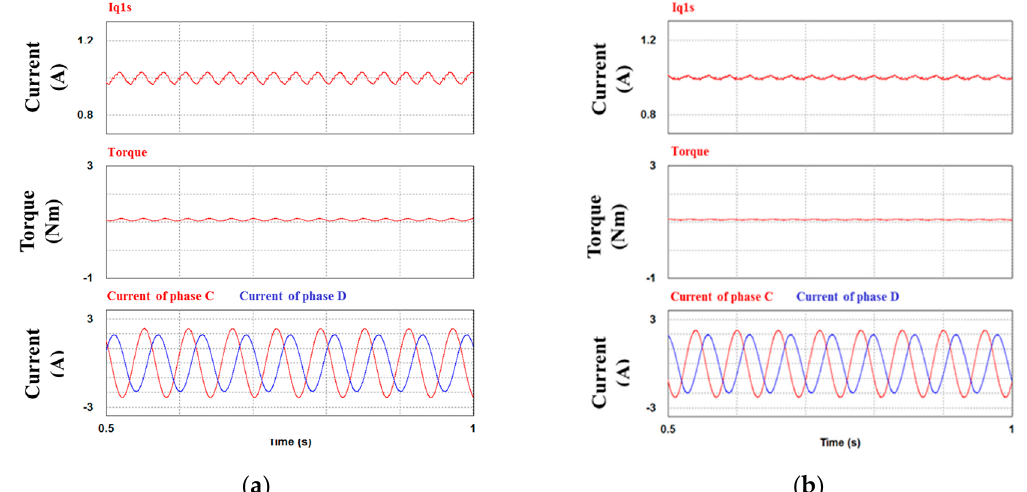
Figure 12. Simulation result of fault ‐ tolerant under open fault phases B in i q1s = 1 A and 1000 rpm: ( a ) Without tolerant control; ( b ) With tolerant control.